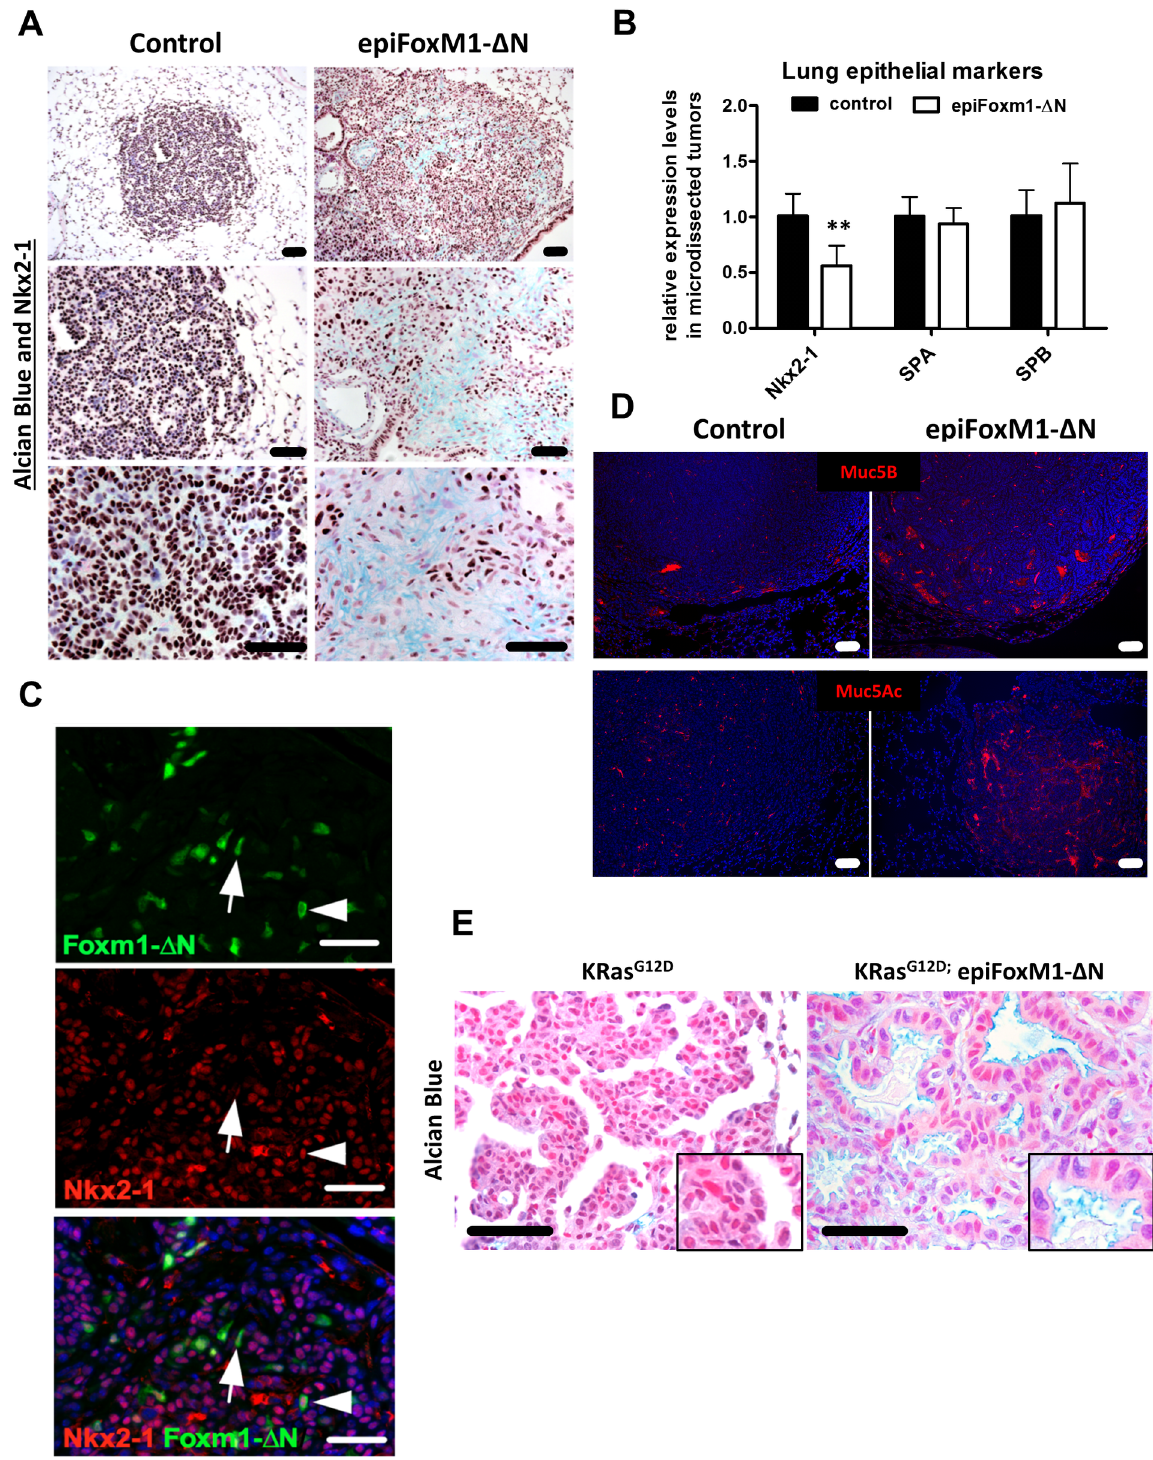
Fig 4. Expression of FOXM1 promotes mucinous characteristics in mouse lung tumors induced either by urethane or Kras G12D . (A) Lungsections form urethane-treated mice (control n = 6 and epiFoxM1- Δ N n = 9 mice) were stained with antibodies againstNkx2-1 and Alcianblue. Tumors in epiFoxM1- Δ N mice were highlypositive for mucus (blue) and had low Nkx2-1 protein levels (brown). (B) Nkx2-1 mRNA was decreased in microdissected epiFoxM1- Δ N tumors (n = 5) comparedto control tumors (n = 5) as shown by qRT-PCR. β -actin mRNA was used for normalization. Data represent mean ± SD of three independentdeterminations